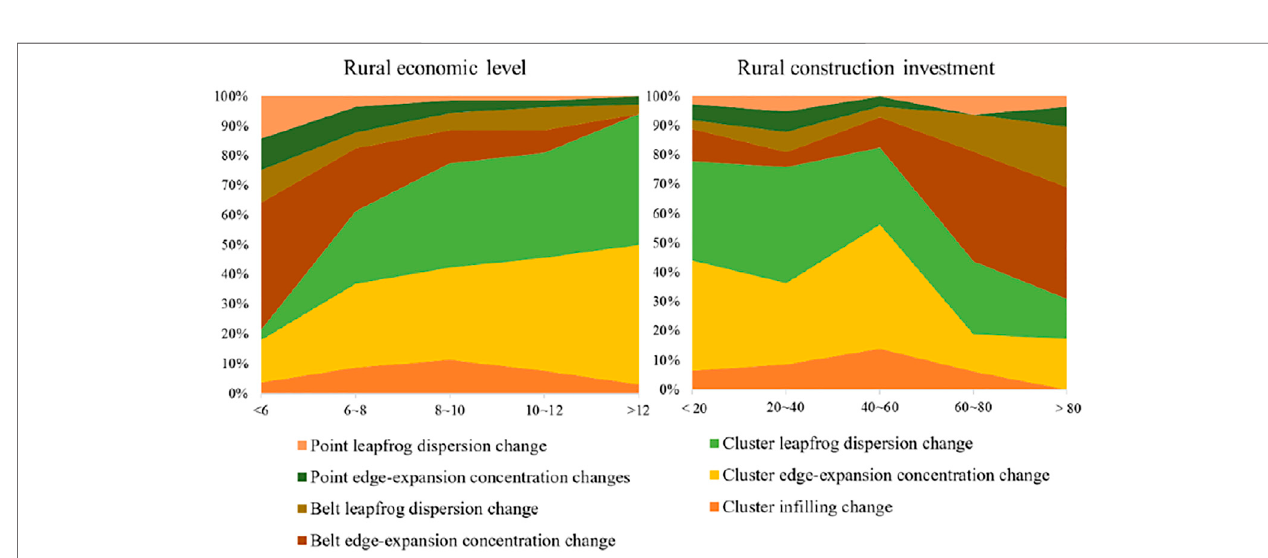
FIGURE 12 | Distribution characteristics of the dynamic spatial pattern of RRL under the public service gradient.